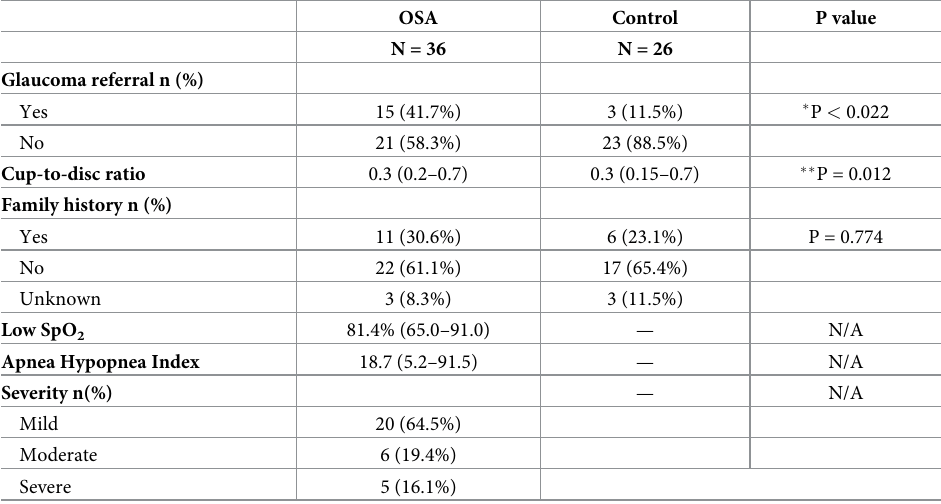
Table 5. Risk factors for glaucoma and need for referral to a glaucoma specialist.